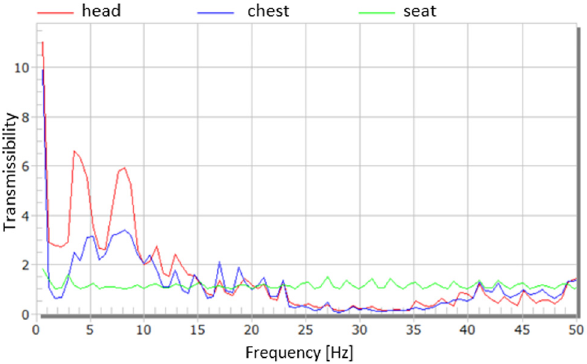
Figure 5: The range of transmissibility of the vertical vibrations of the whole body to the seat, chest, and head as a function of the frequency for the 10 Hz excitation.